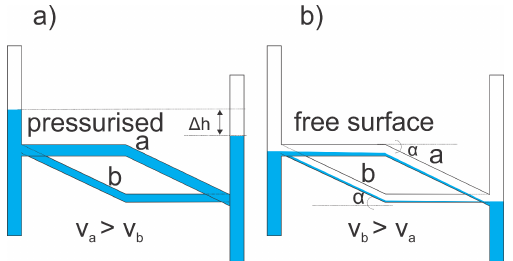
Figure 16. Quasi-stable state for the same scenario as in Fig. 11 with dissolution kinetics for